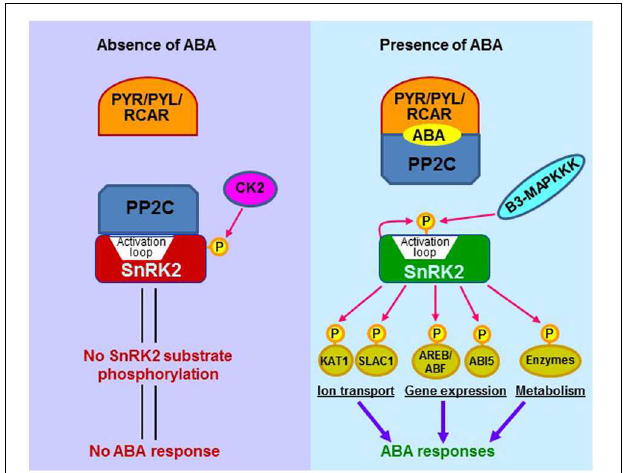
FIGURE 2 | The schematic representation of major ABA signaling pathway in plants with and without ABA presence. The core components in ABA signaling include ABA receptors (PYR/PYL/RCAR), PP2C phosphatases (negative regulators), and SnRK2 kinases (positive regulators). In the absence of ABA, PP2Cs associate with SnRK2s and prevent the activation of SnRK2s. The inactive SnRK2s are unable to phosphorylate downstream substrates, and thus signal transduction is not occurring. In the presence of ABA, PYR/PYL/RCAR receptors bind to ABA and interact with PP2Cs, which release SnRK2s. The SnRK2s are then activated by autophosphorylation of the activation loop. The active SnRK2s can phosphorylate downstream substrate proteins, including transcription factors, ion channels, and enzymes such as NADPH oxidases, thereby inducing ABA responses. SnRK2s are subjected to regulation by other protein kinases. A Raf-like kinase (B3-MAPKKK) has been shown to activate SnRK2 through phosphorylating the activation loop, whereas casein kinase 2 (CK2) can phosphorylate SnRK2’s carboxyl-terminal serine residues, thereby enhancing SnRK2-PP2C interaction and inactivating SnRK2. Catalytically active SnRK2 is shown in green and inactive SnRK2 is in red. ABF, ABA-responsive element binding factor; ABI5, ABA insensitive 5; AREB, ABA-responsive element binding protein; B3-MAPKKK, B3-group Raf-like MAP kinase kinase kinase; KAT1, potassium channel in Arabidopsis thaliana 1; PP2C, Protein phosphatase 2C; PYR, pyrabactin resistance; PYL, PYR-related; RCAR, regulatory component of ABA receptor; SLAC1, slow anion channel 1; SnRK2, sucrose nonfermenting-1-related protein kinase